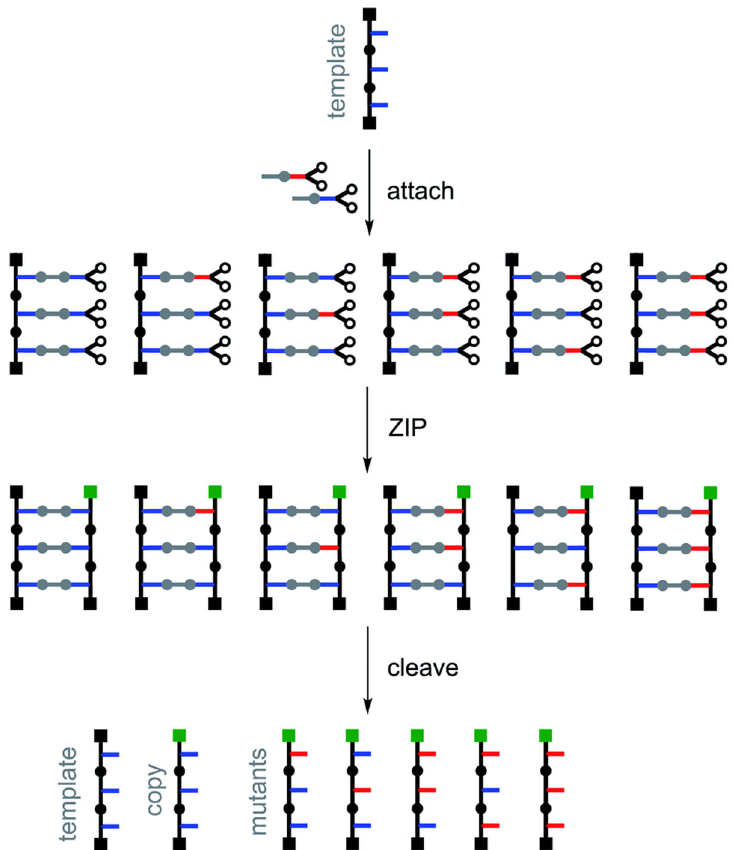
Fig. 1 Controlled mutation in a synthetic replicator. The use of isosteric monomers in a replicator based on covalent inter-strand interactions allows for the rate of introduction of sequence mutations to be controlled solely by tuning the monomer composition. Reproduced from Chem. Sci . 2021,